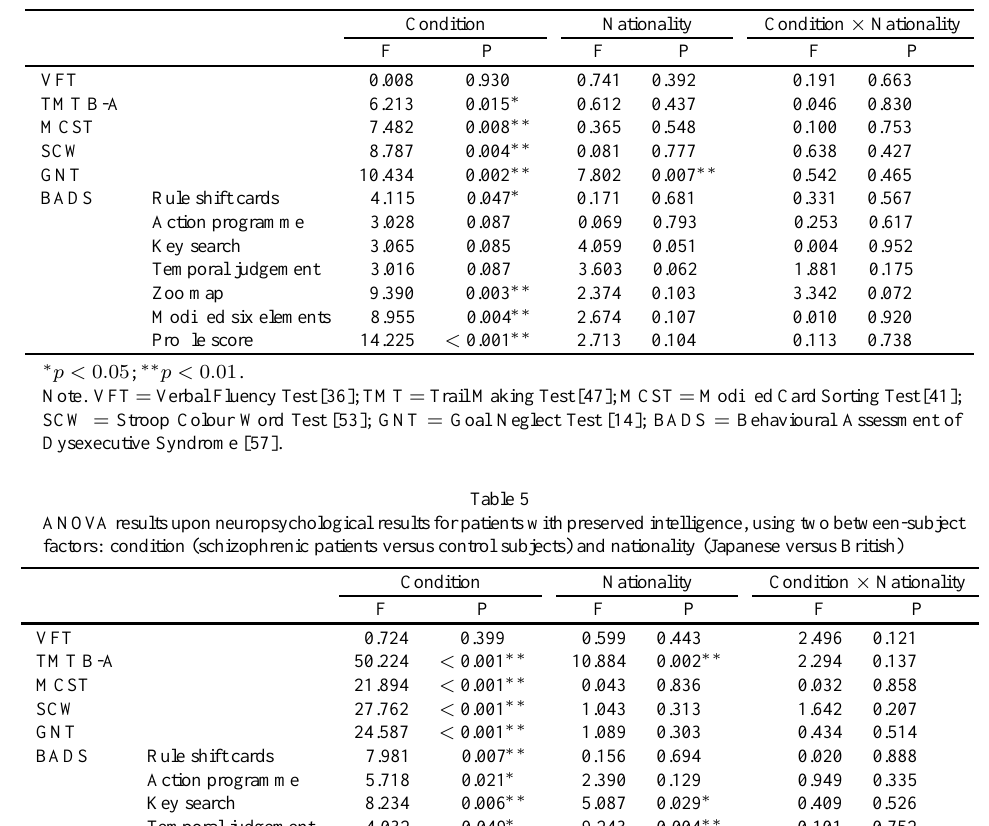
Table 4 ANCOVA results upon neuropsychological results, using the RAPM score, as covariate, and two between-subject factors: condition (schizophrenic patients versus control subjects) and nationality (Japanese versus British)